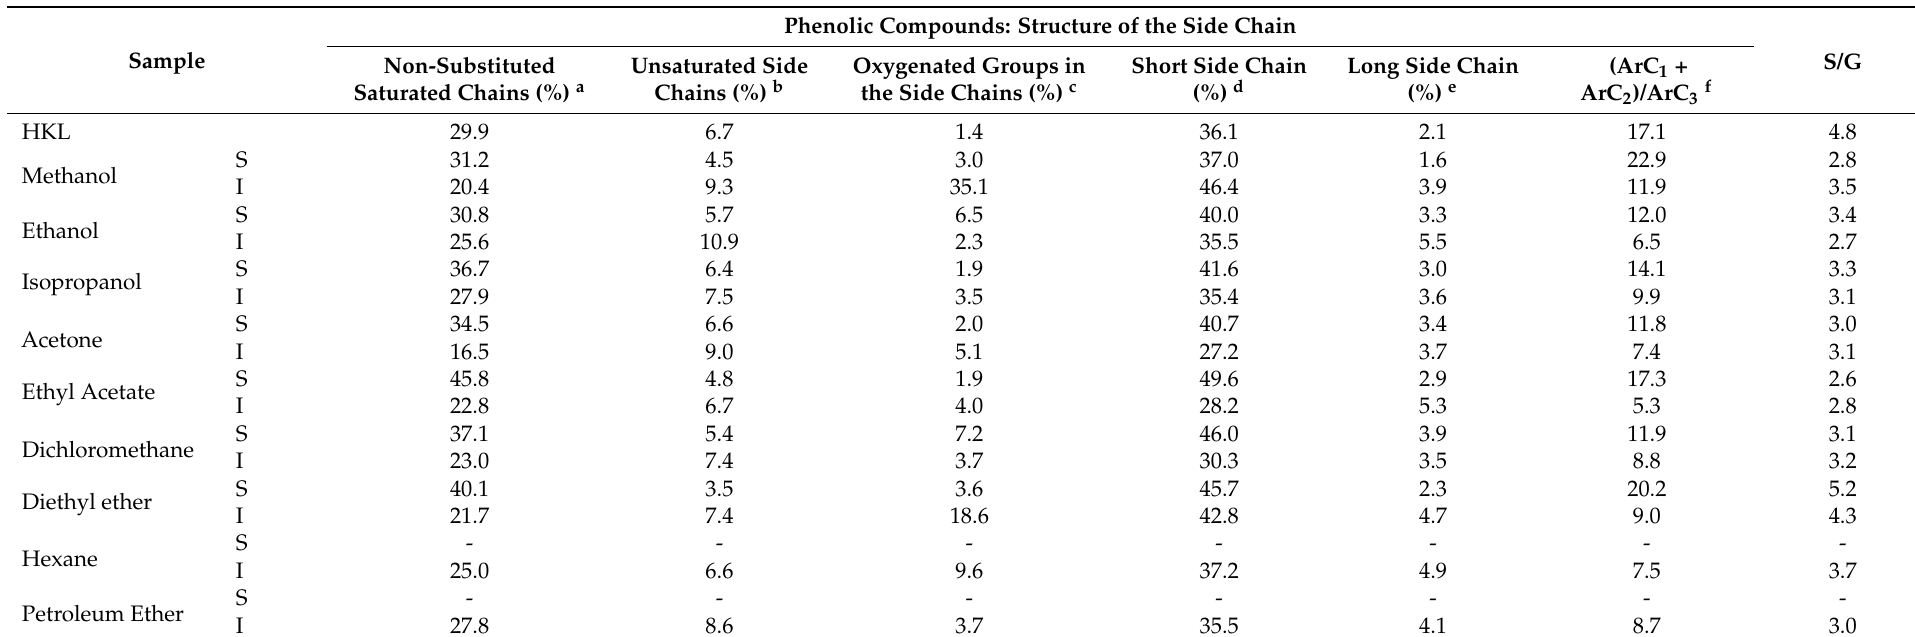
Table 2. Relative content (%) of phenolic-type compounds according to their structural characteristics and S/G